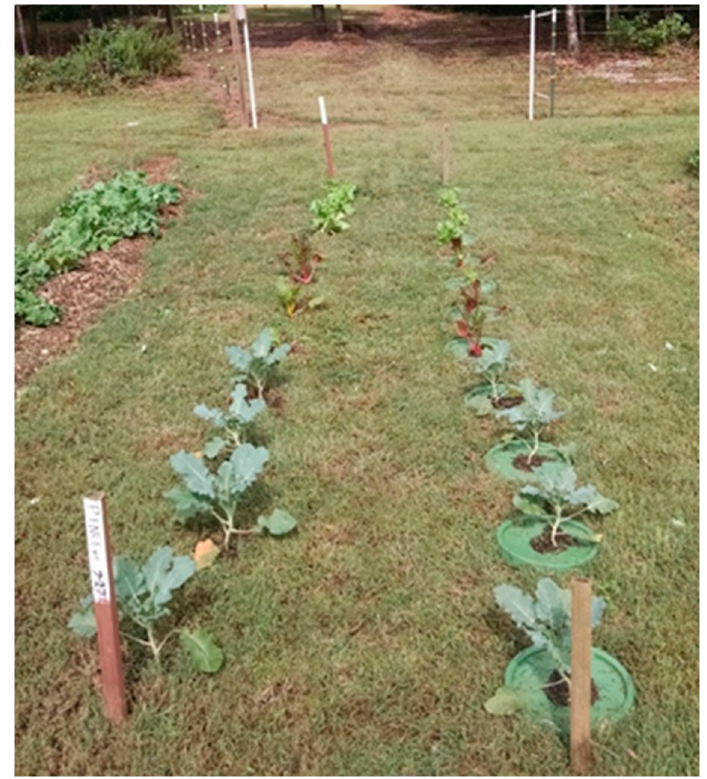
Figure 4. Volunteer trial with DP-10 treatment and the VLP treatment.